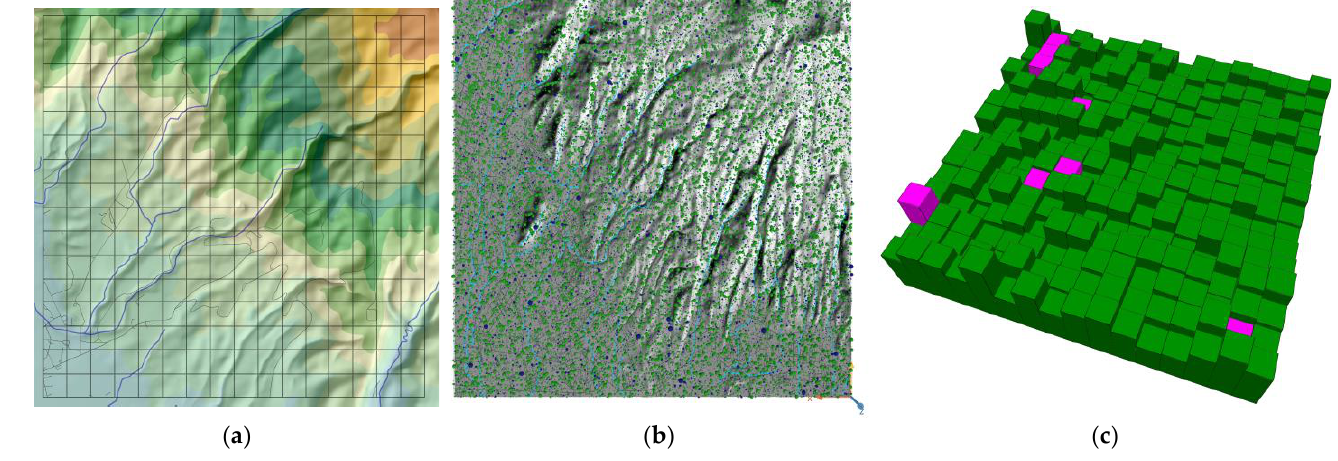
Figure 2. Screenshots of the landscape: ( a ) landscape divided into parcels, ( b ) landscape populated with initial distribution of trees, and ( c ) landscape visualized with initial volume of parcels and location of protected parcels (in magenta).